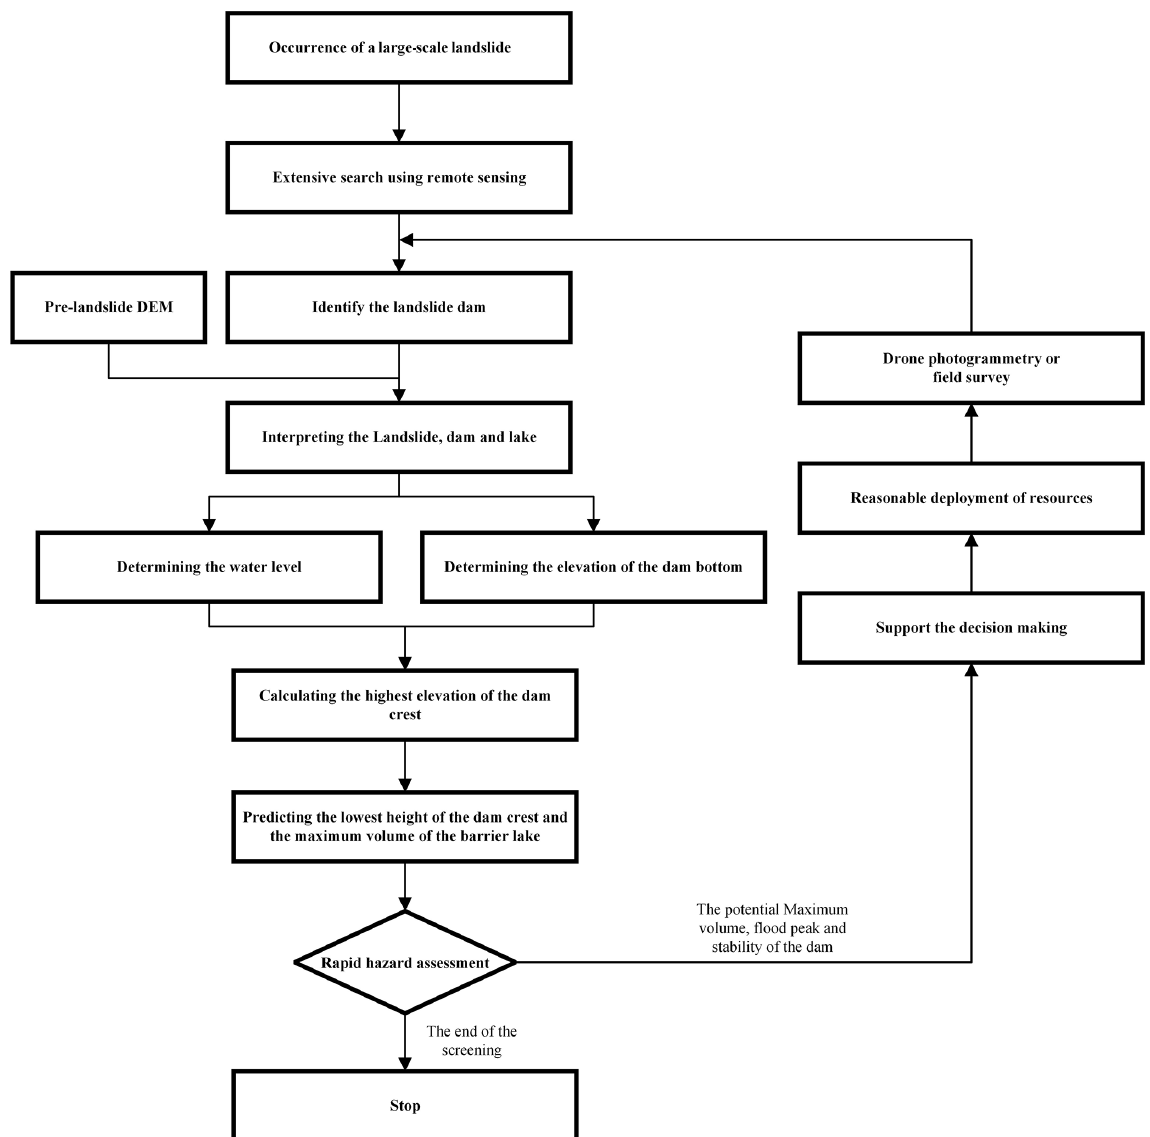
Figure 2. The procedure for obtaining the height of the dam crest and completing the hazard